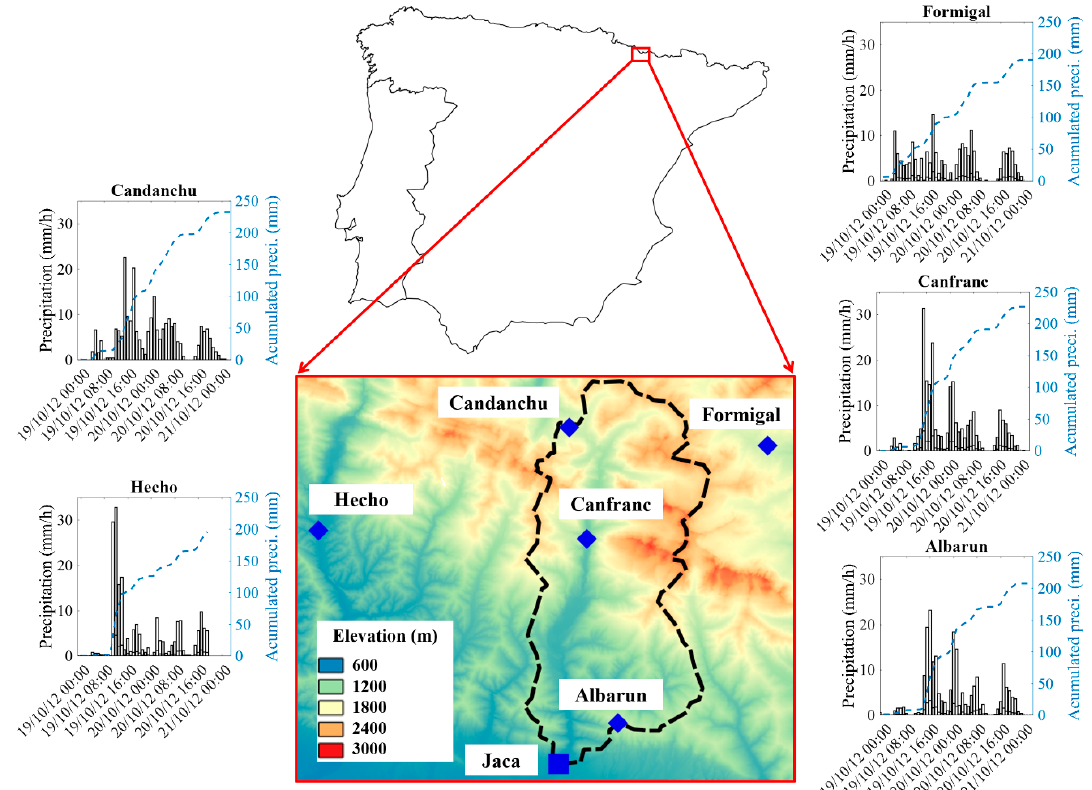
Figure 18. Location of the upper basin of the Aragon river (enclosed by a black dashed line) in the Iberian Peninsula. Blue diamonds represent the location of the available rain gauges. The blue square represents the gauging station at Jaca. The hyetographs (bar graphs) and the accumulated precipitations (blue dashed lines) recorded during the event are also shown.